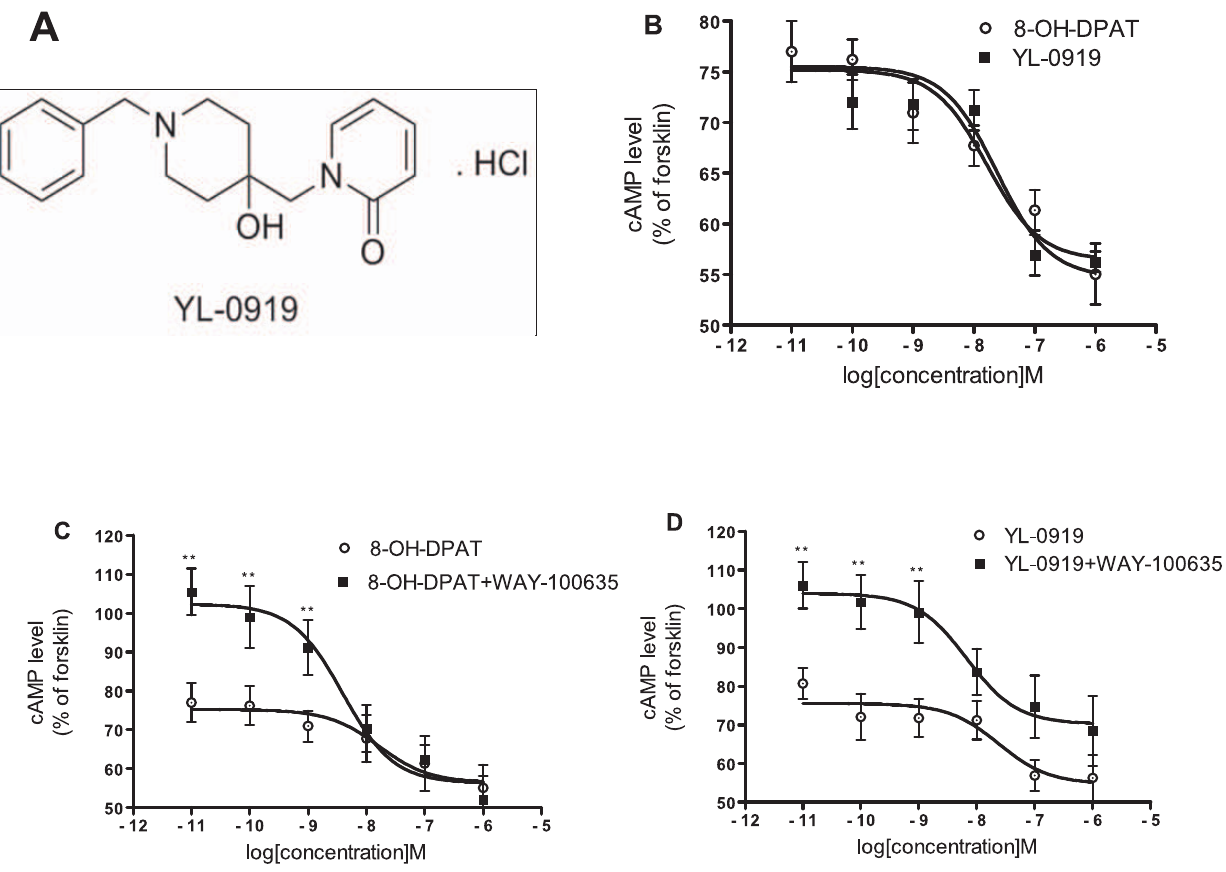
Figure 1. The intrinsic functional activities of YL-0919 on 5-HT 1A receptor. A. The chemical structure of YL-0919. B. C. D. cAMP assays. Both 8-OH-DPAT (10 2 11 , 10 2 6 M) and YL-0919 (10 2 11 , 10 2 6 M) concentration-dependently inhibited forskolin-stimulated cAMP formation (B). WAY-